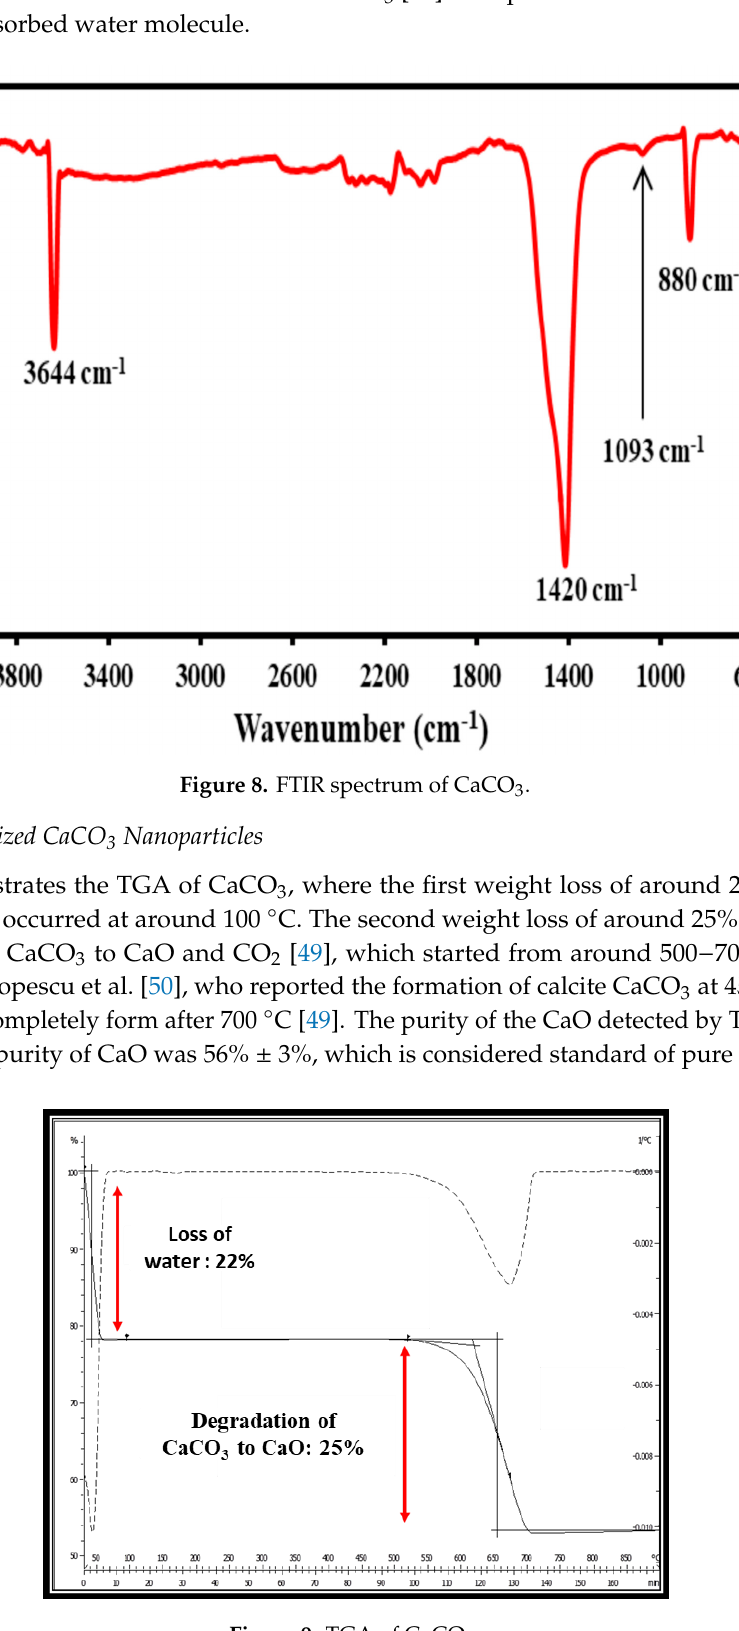
Figure 10. FTIR spectrum of CaO. 3.7 XRD Analysis of CaO Nanoparticles Figure 11 shows the XRD analysis of CaO powder derived from cockle shells. The high and narrow intense peaks depict the structural crystallization of the CaO. The formation of CaO can be observed at 2θ = 29, 36, 39, 47, and 48°, which is accordance with Bai et al. [53]who prepared CaO from 0.3 M sodium carbonate (Na 2 CO 3 ) and 0.3 M calcium chloride (CaCl 2 ). Therefore, the formation of the CaO derived from cockle shell can be successfully synthesized by the sol–gel method.